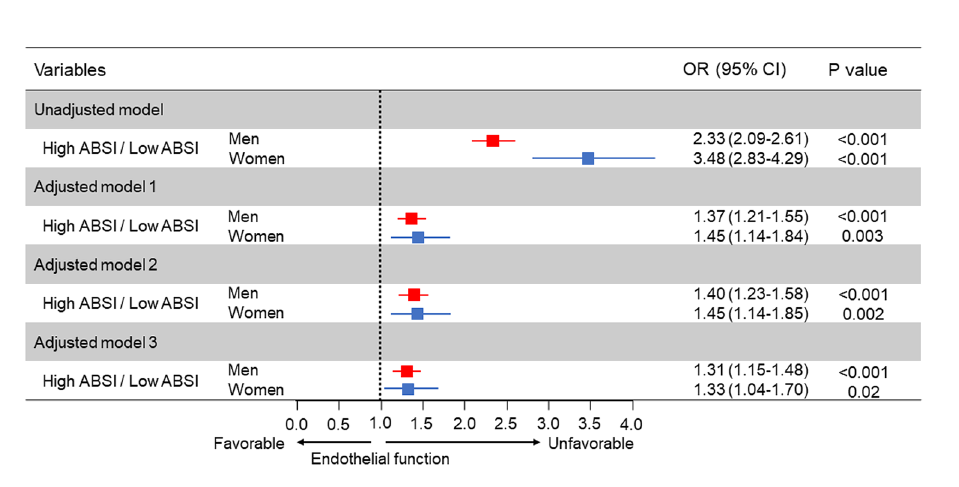
Figure 4. Odds ratios and 95% confidence intervals for a low quartile of flow-mediated vasodilation (FMD) of high a body shape index (ABSI) using the low ABSI group as the reference. Low quartile of FMD indicates less than 3.6% in men and less than 3.1% in women. Low ABSI indicates less than 0.0796 in men and less than 0.0823 in women. Model 1: Adjusted for age. Model 2: Adjusted for age, body mass index, and smokers. Model 3: Adjusted for age, body mass index, presence of hypertension, dyslipidemia, and diabetes, and